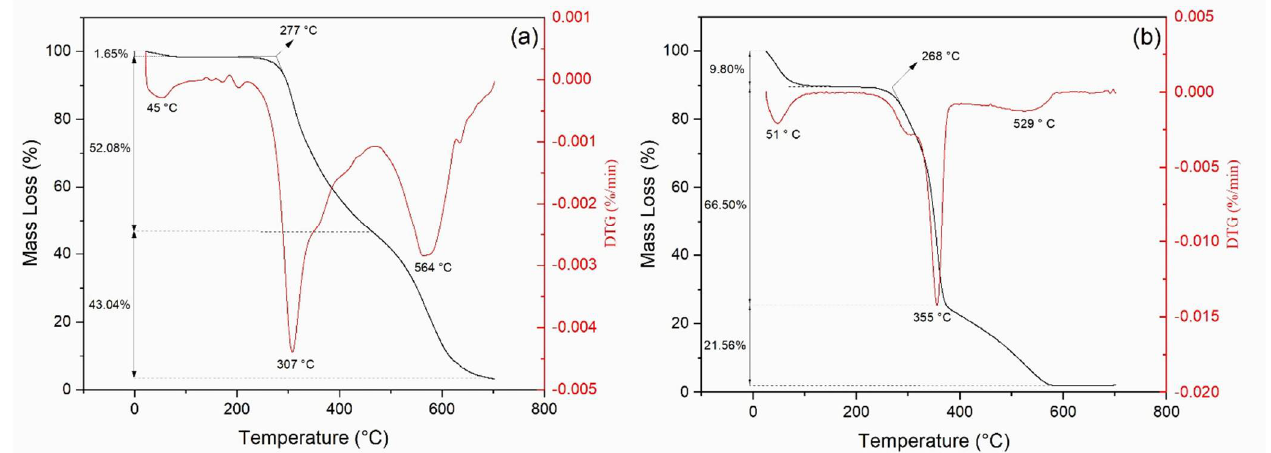
Figure 4. TG and DTG curves for (a) epoxy resin; (b) kenaf fibers.